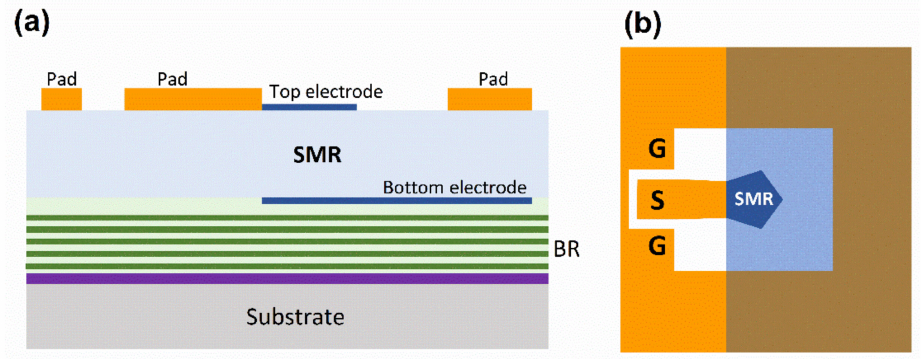
Figure 1. Schematic diagram of the resonator. ( a ) Cross section view; ( b ) Top view of the layout including the electrode and the pad.